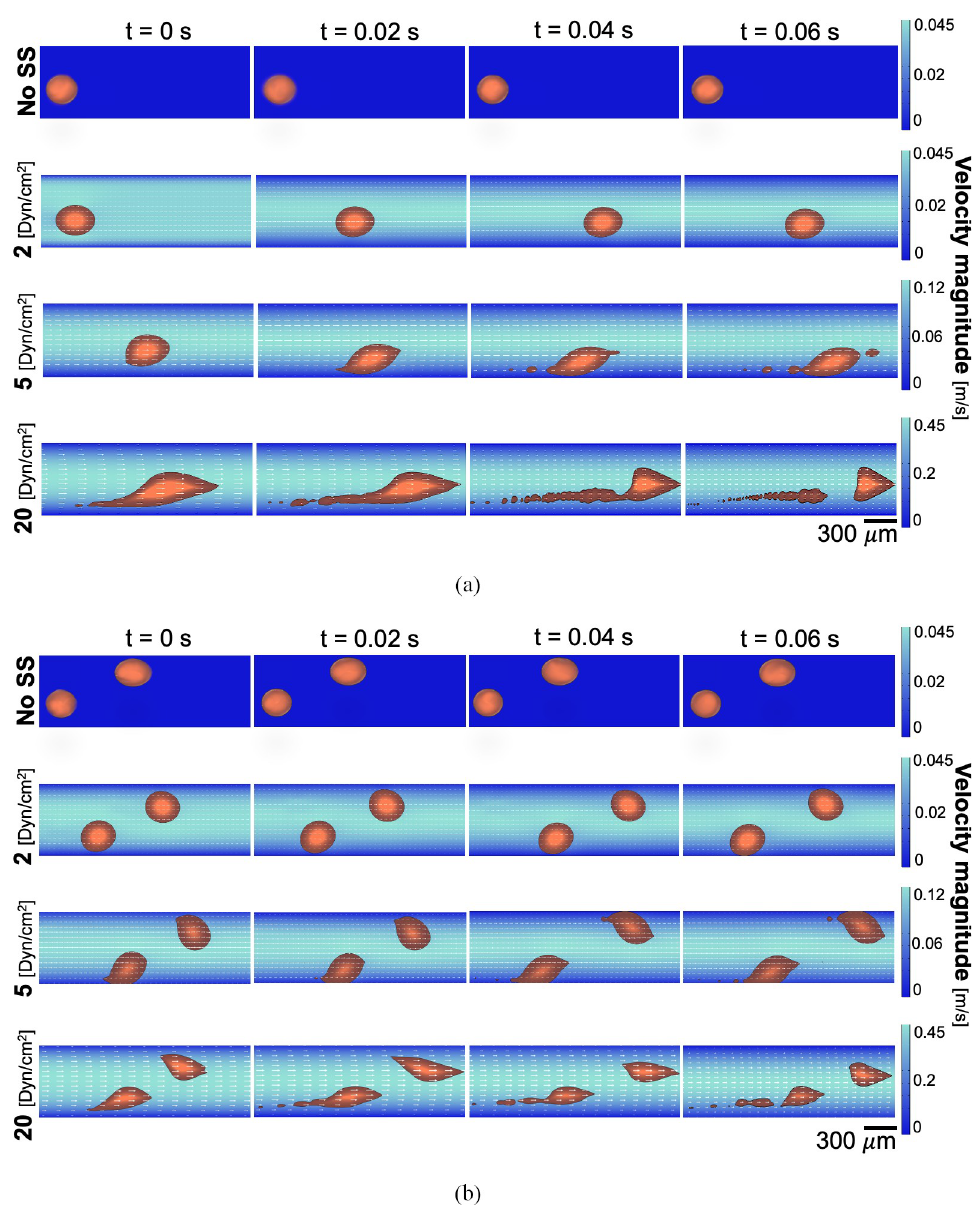
Fig 5. CTC clusters disaggregation. Fluid-dynamic simulation of CTC clusters disaggregation process under fluid flow with (A) one and (B) two clusters circulating. Clusters shape inside the vessel is reported at different time points: t = 0, 0.02, 0.04 and 0.06